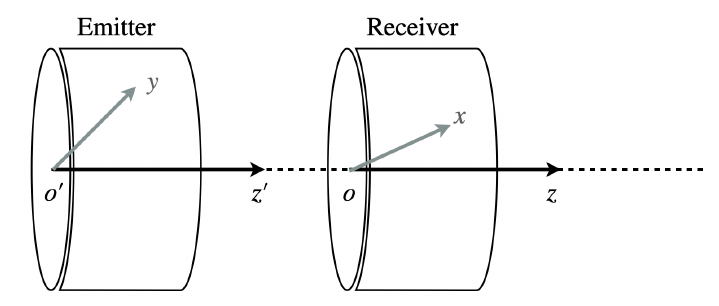
Figure 2 . Coordinate